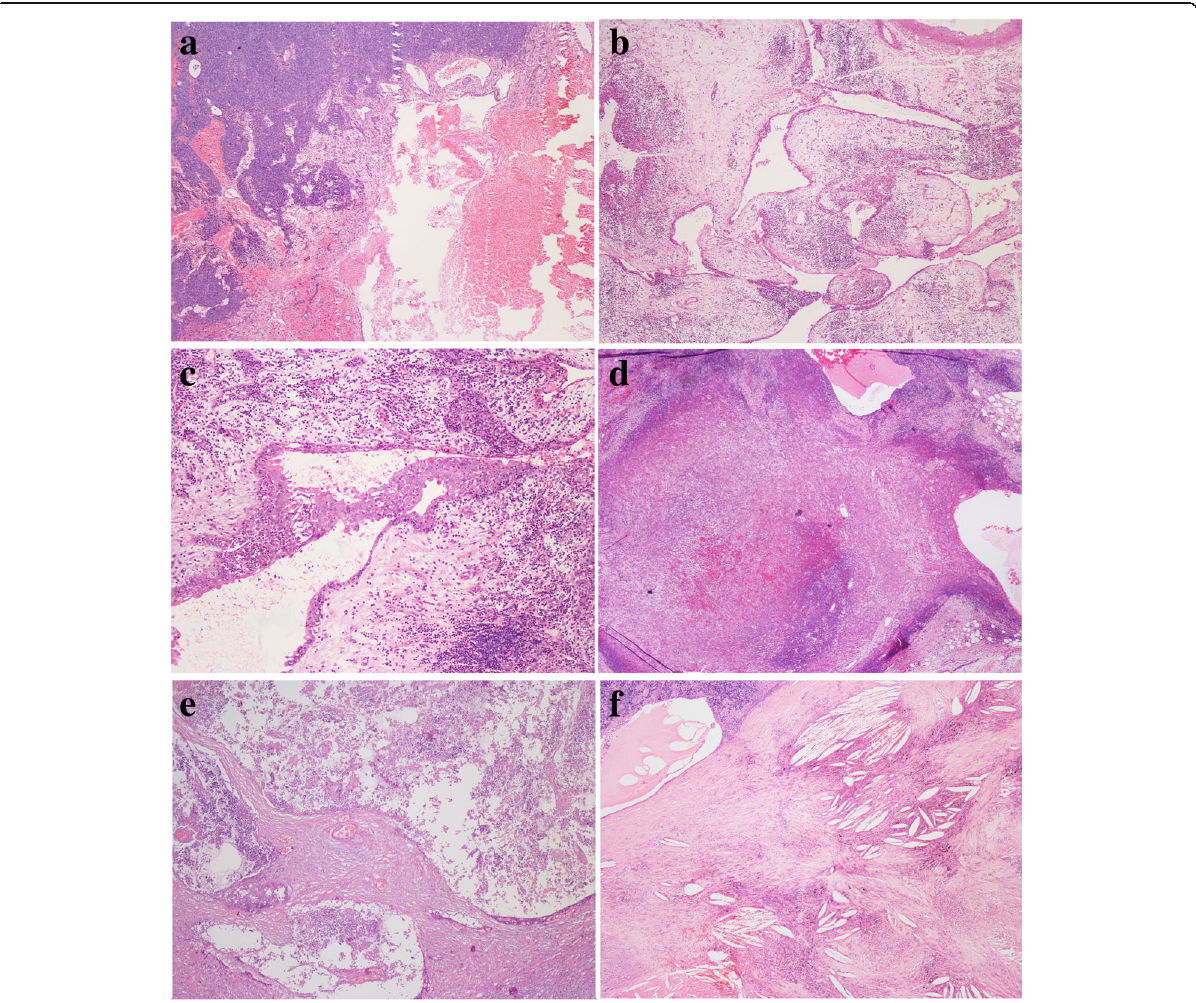
Fig. 4 a Thymoma (left) adjacent to MTC (right), with haemorrhage. b A typical MTC showed remnant thymic tissue in the periphery of the cyst. c MTC lined by squamous epithelium with inflammatory cells infiltration. d Atypical type A thymoma was continuous with the cyst lining. e MTC displaying prominent necrosis. f MTC displaying cholesterol